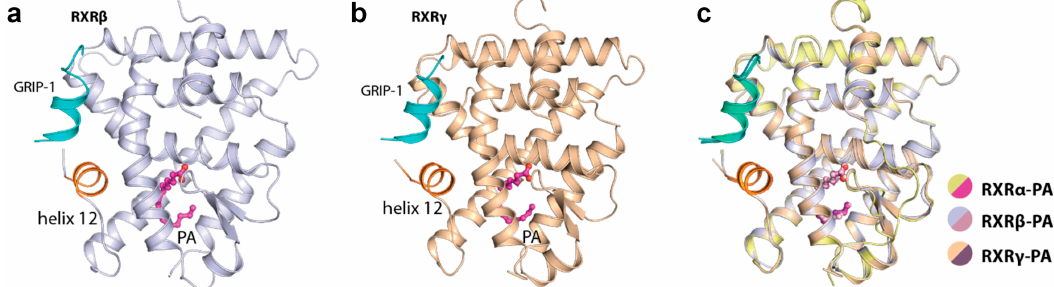
Figure 2. Palmitic acid (PA) bound to all RXR isoforms and induced similar active conformations. Overview of the tertiary complexes between PA, GRIP-1 co-regulator peptide and RXR β ( a ) and RXR γ ( b ). ( c ) Superimposition of RXR α , RXR β and RXR γ structures reveals highly similar active conformation in this tertiary complex with PA and the peptide.